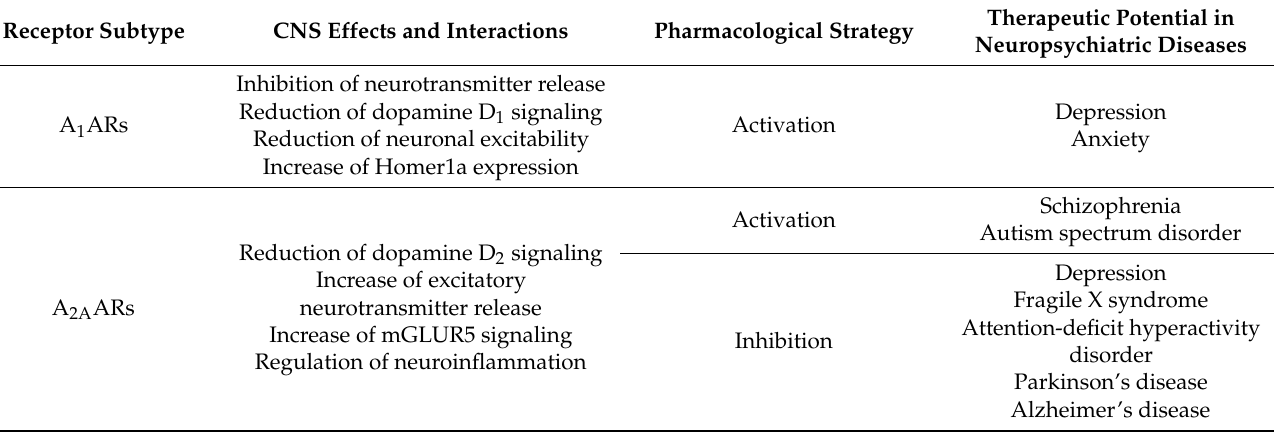
Table 1. Effect of A 1 and A 2A ARs in the CNS and therapeutic potential of their modulation in neuropsychiatric